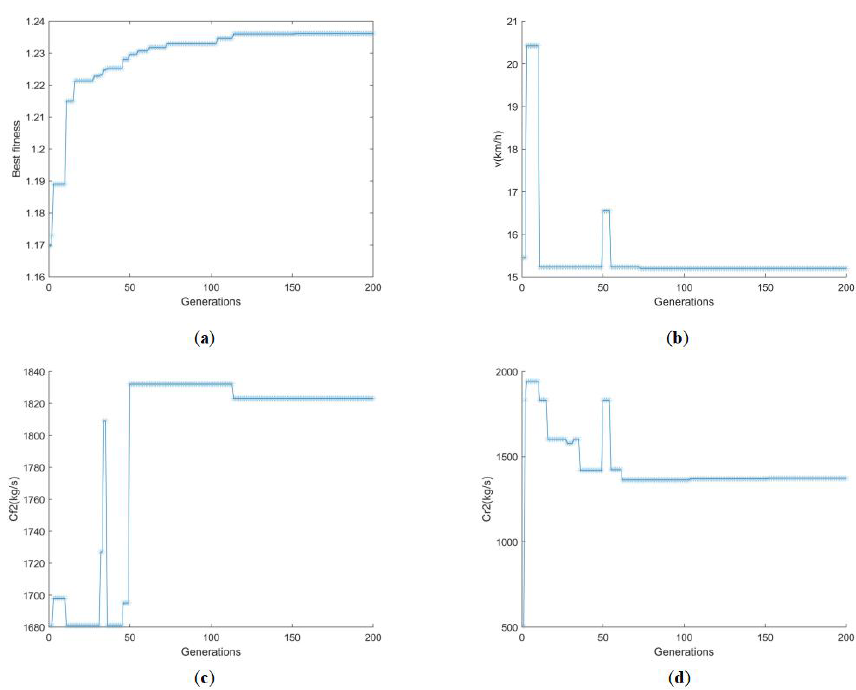
Figure 7. The iterative process of each variable of the semi-active suspension vehicle. (a) All individuals’ optimal fitness. (b) Optimal